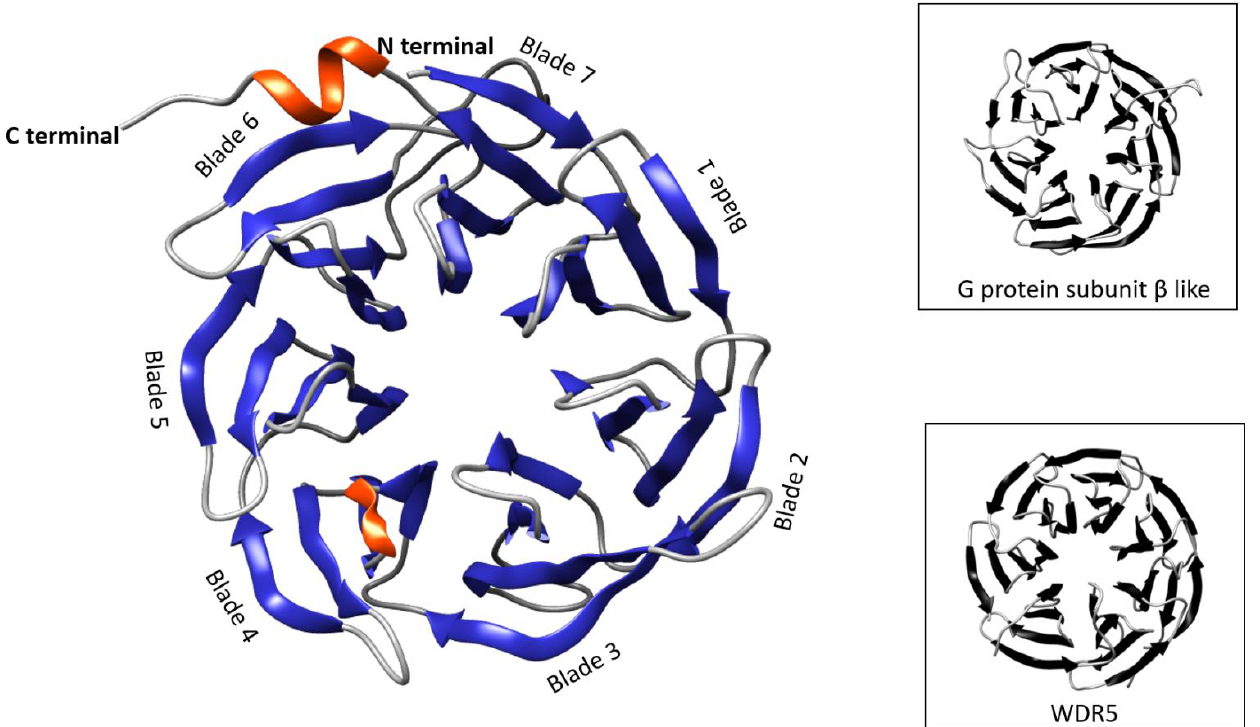
Figure 3. Secondary structure of TRIP-1. The structure of TRIP-1 predicted by I-TASSER revealed several beta sheets conforming to the seven-bladed beta-propeller structure (grey-loop, blue-beta sheets, and orange-alpha helix). The figures in the box are the structures of GPSß (4JSP:D) and Wdr5 (RCSB PDB ID, 3UVL: A).